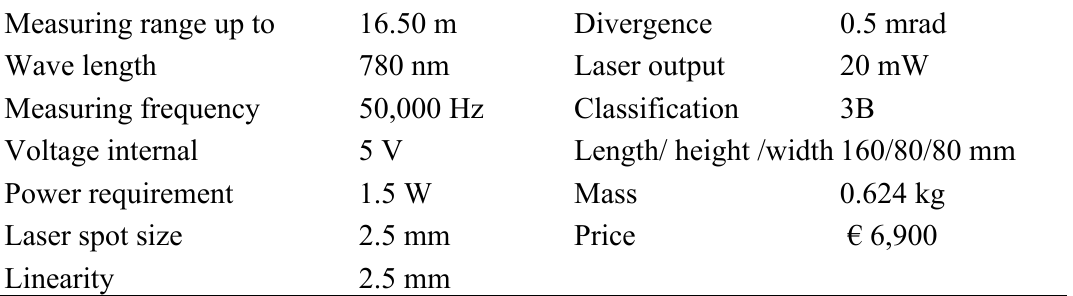
Table 2. Technical data of the sensor ACUITY AccuRange 4000-LIR (manufacturer’s